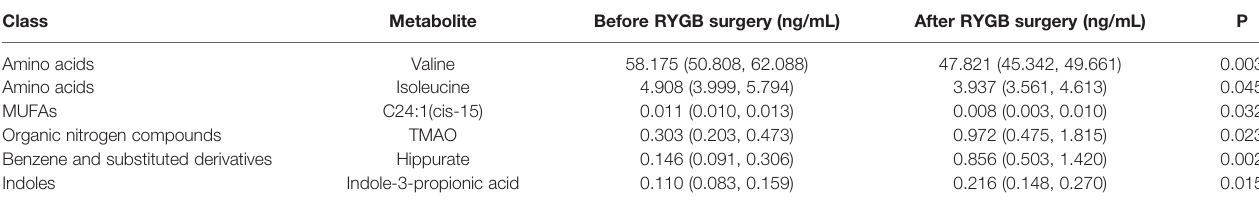
TABLE 3 | Metabolomic changes in the OSA remission group after